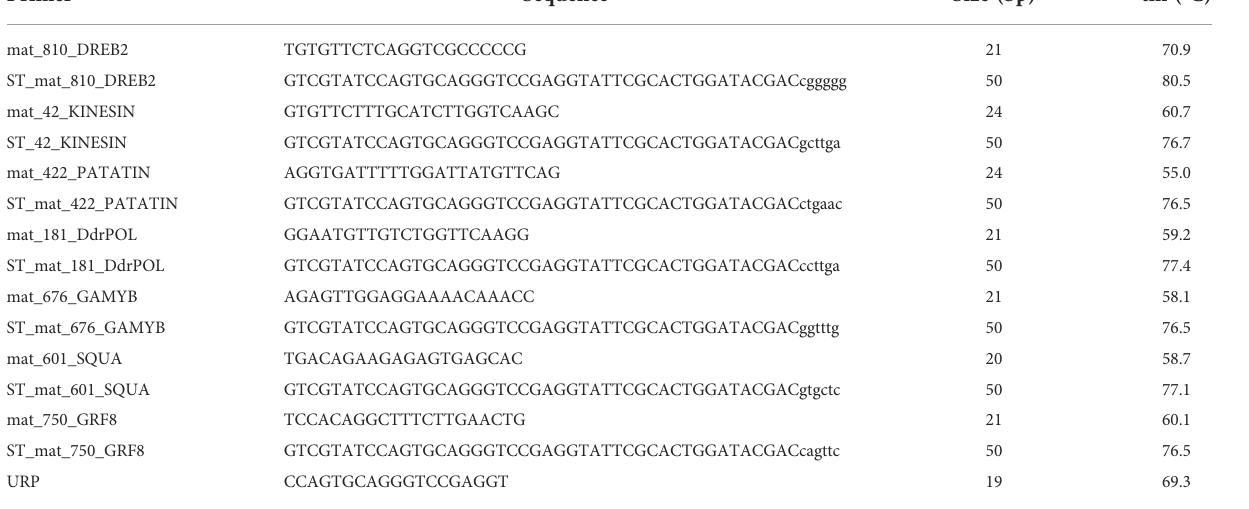
TABLE 1 Primers designed for stem-loop miRNAs ampli fi cation. Primer